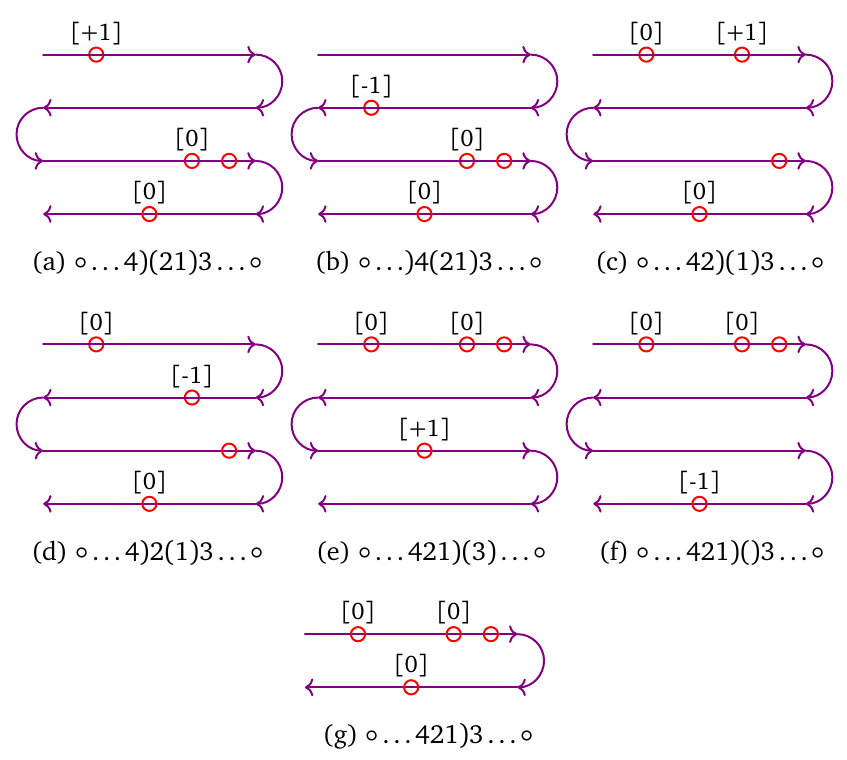
Figure 5: Wing spread ( w = 1 ) configurations of the basic wing shown in fig (g) with the wing positions marked for every wing operator. Note that the future turning-point operator is always placed before the future turning-point,i.e., in canonical arrange- ment. Each wing configuration is completely specified by wing positions { x of the three wing operators. The wing-spread can be computed from the wing posi- tions by using the formula w = | x